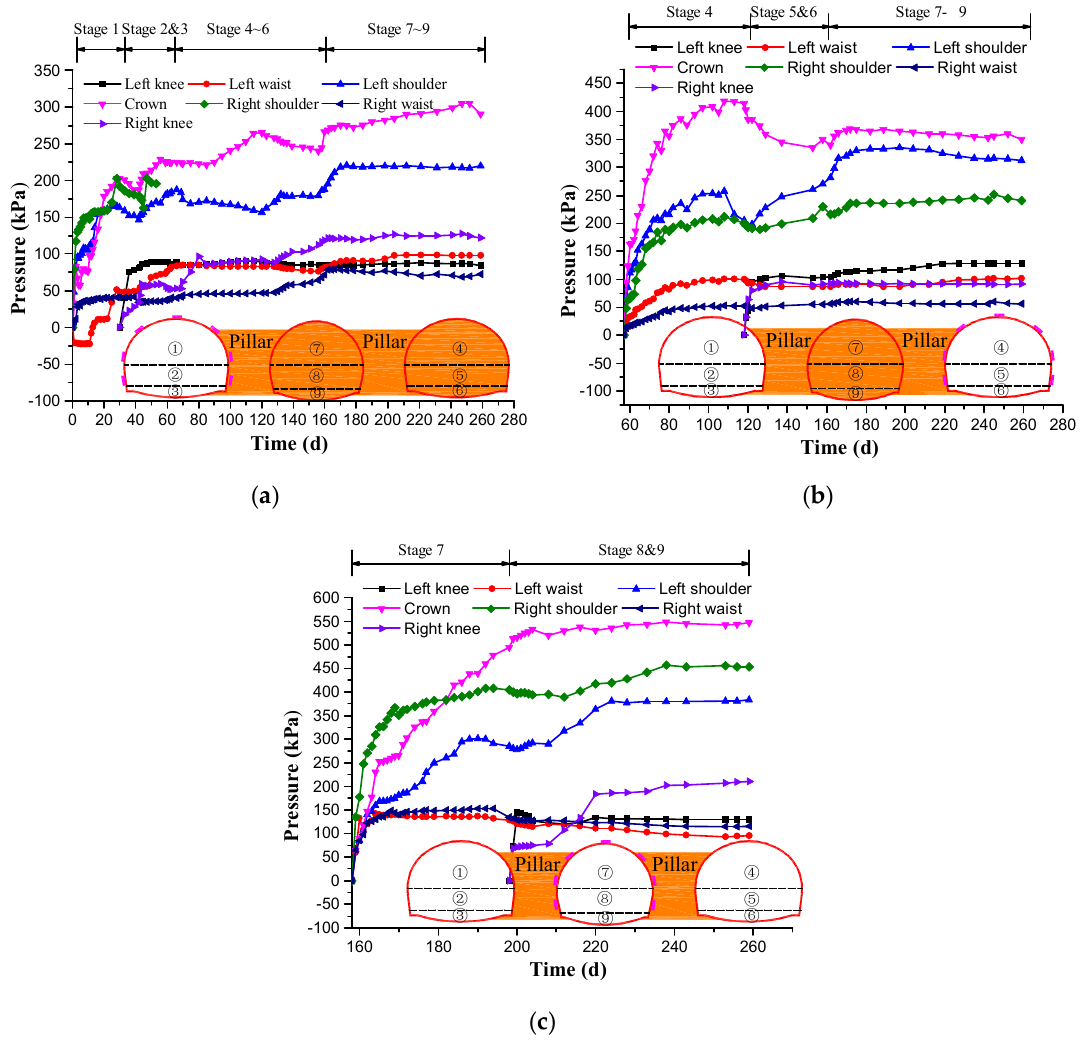
Figure 6. Development of surrounding rock pressure at section DK68 + 220: ( a ) Left tunnel; ( b ) Right tunnel; ( c ) Middle tunnel.